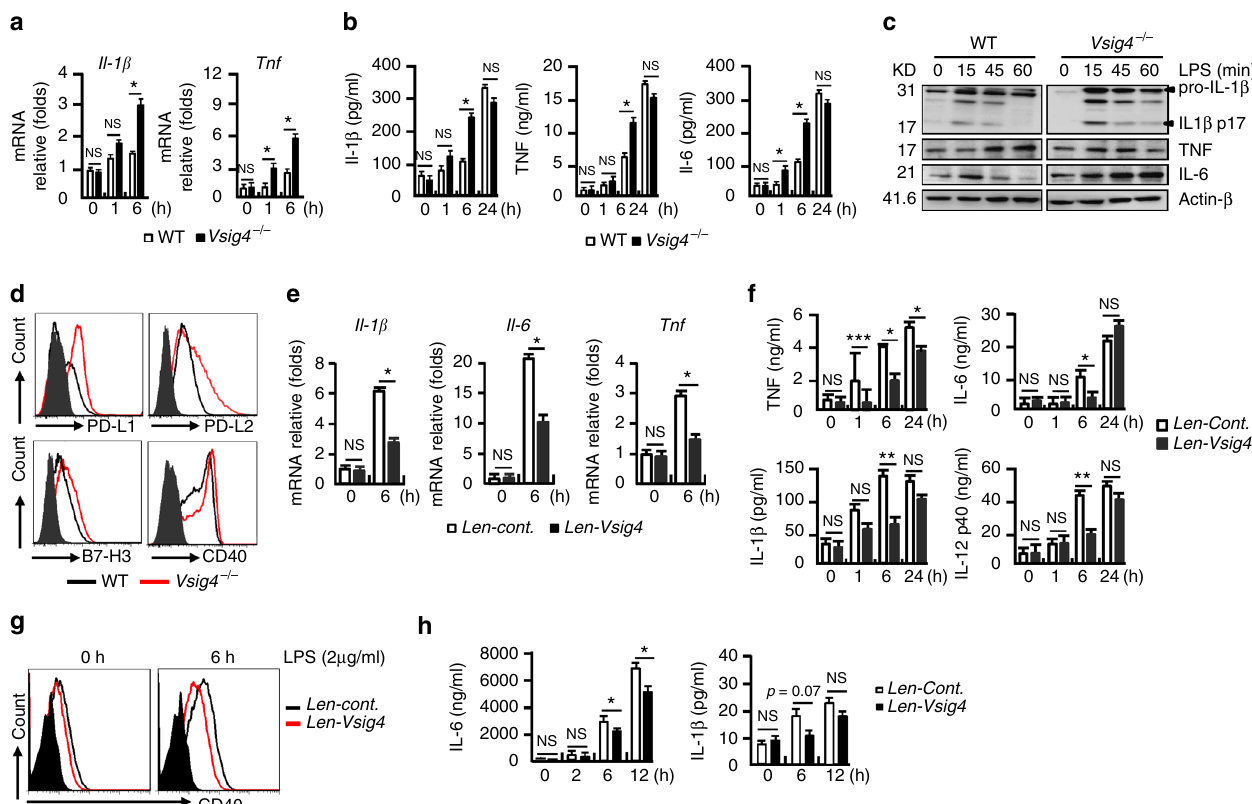
Fig. 3 VSIG4 impedes LPS-induced macrophage M1 polarization in vitro. PEMs were treated with LPS (2 μ g/ml), a qRT-PCR analysis of Il-1 β and Tnf transcripts. b ELISA of cytokines in cultured supernatants. c Western blot analyzing cytokine protein expression. d Flow cytometry analyzing surface expression of activation markers. RAW264.7 cells stably infected with lentiviral control vectors ( Len-cont .) or vectors encoding Vsig4 ( Len-Vsig4 ), cells were further treated with LPS (2 μ g/ml), e qRT-PCR analysis of Il-1 β , Il-6 , and Tnf transcripts. f ELISA detecting cytokines in cultured supernatant. g Flow cytometry analyzing surface expression of CD40. h C3 − / − BMDMs were tranfected to overexpress VSIG4, and cells were further treated with LPS (2 μ